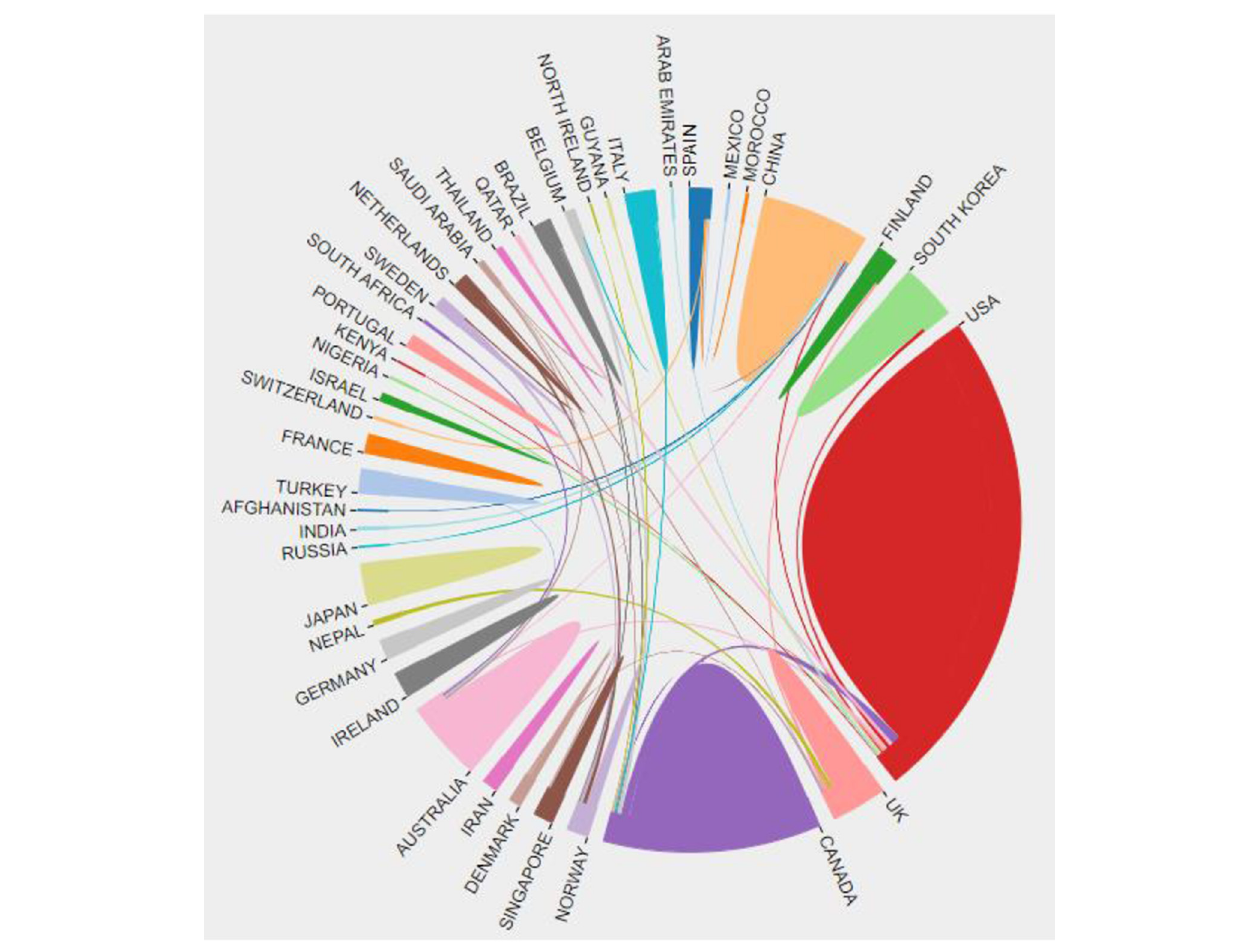
FIGURE 3 | The cooperation of countries or regions that contributed to publications on applying VR to the study of nursing from 2012 to 2021. Different colored areas represent various countries. The size of the color block area describes the number of documents sent. The connection between different color blocks represents the countries’ cooperative